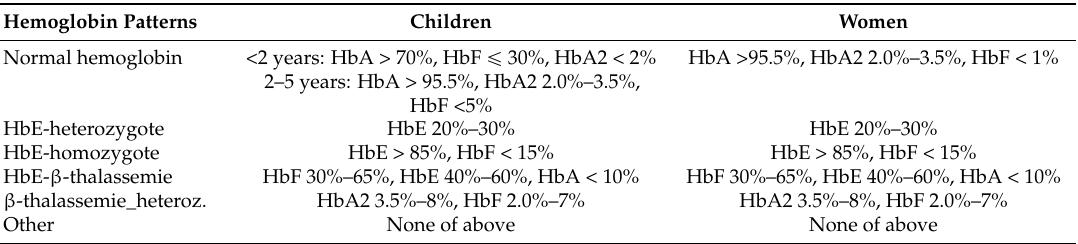
Table 1. Classification criteria for hemoglobin patterns obtained by